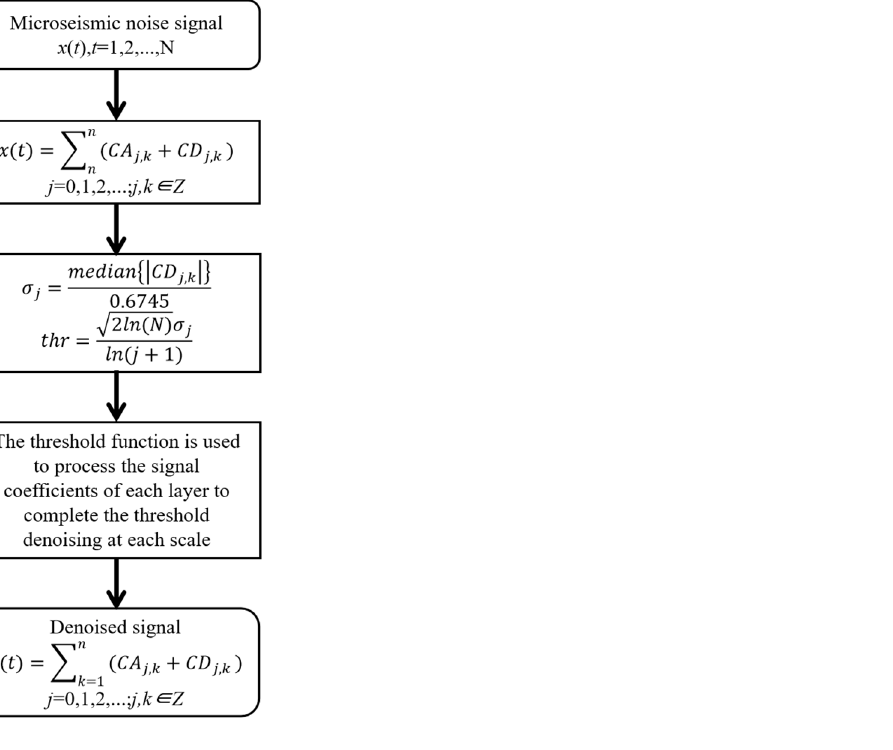
Figure 3. Method flow, the { CA j,k } is approximate component and { CD j,k } is detailed component.